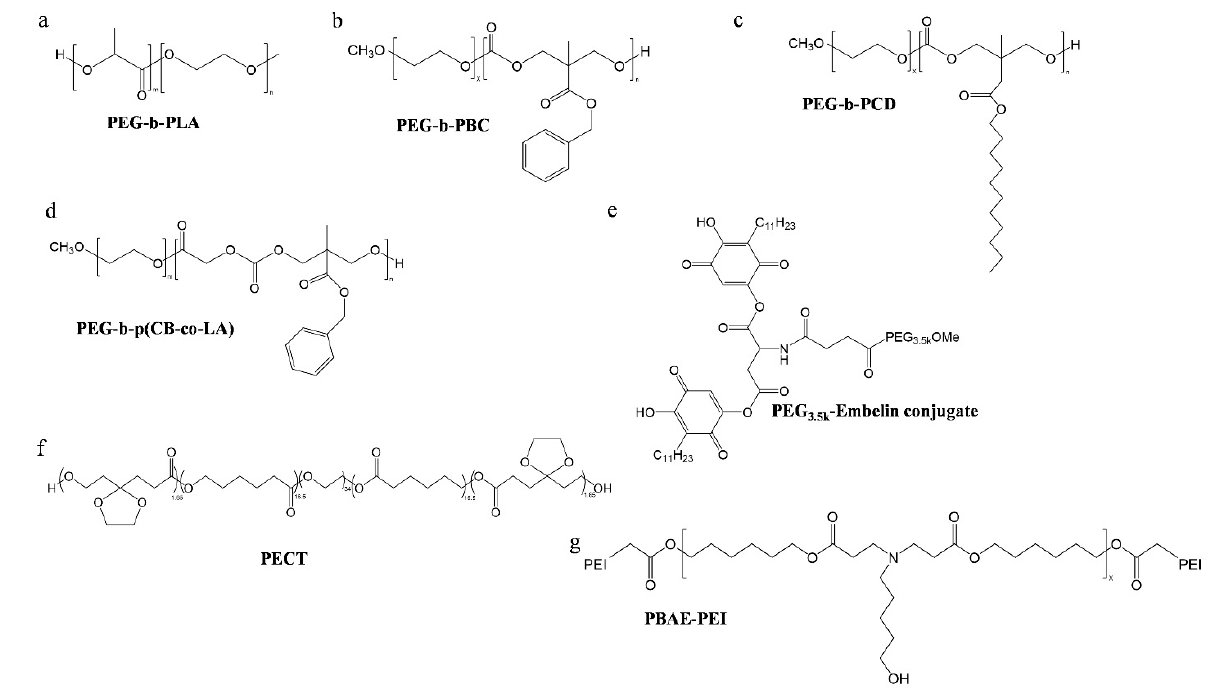
Figure 2. Chemical structures of copolymers used for embelin drug delivery systems. ( a ) Polyeth ‐ lene glycol- block -polylactic acid. ( b ) Polyethylene glycol- block -poly(2-methyl-2-benzoxycarbonyl- ylene glycol ‐ block ‐ polylactic acid. ( b ) Polyethylene gly ‐ propylene carbonate). ( c ) Polyethylene glycol- block -poly(2-methyl-2-benzoxycarbonyl-propylene col ‐ block ‐ poly(2 ‐ methyl ‐ 2 ‐ benzoxycarbonyl ‐ propylene carbonate). ( c ) Polyethylene gly ‐ carbonate-graft-dodecanol). ( d ) Polyethylene glycol- block -poly(carbonate-co-lactide). ( e ) Polyethy- col ‐ block ‐ poly(2 ‐ methyl ‐ 2 ‐ benzoxycarbonyl ‐ propylene carbonate ‐ graft ‐ dodecanol). ( d ) Polyeth ‐ ylene glycol ‐ block ‐ poly(carbonate ‐ co ‐ lactide). ( e ) Polyethylene glycol (3500) ‐ embelin conjugate. ( f ) lene glycol (3500)-embelin conjugate. ( f ) Poly{ ε Poly{ ε‐ caprolactone ‐ co ‐ 1,4,8 ‐ trioxa[4.6]spiro ‐ 9 ‐ undecanone)–poly(ethylene glycol)– Poly[(1,6 ‐ hexanediol)diacrylate ‐β‐ 5 ‐ hydroxyamylamine] ‐ Polyethyleneimine .